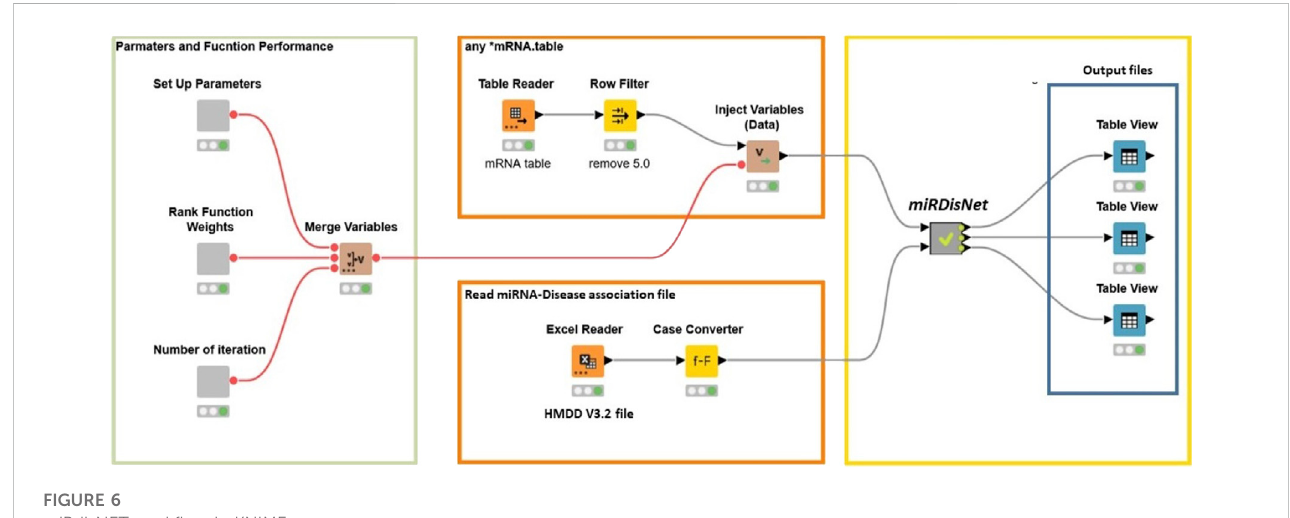
FIGURE 6 miRdisNET work fl ow in